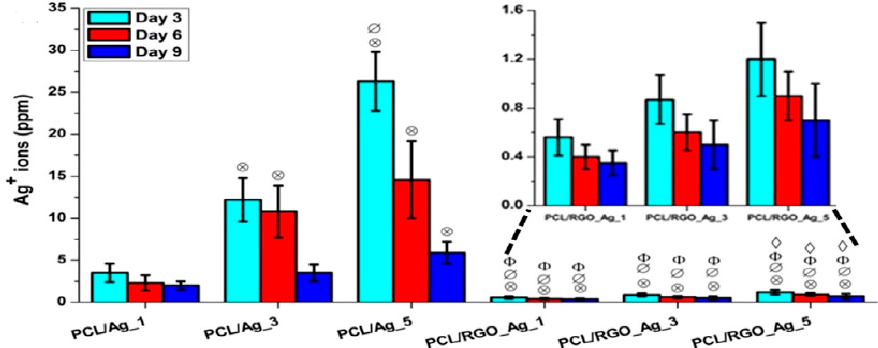
Figure 29. Released silver ions from PCL/Ag and PCL/RGO-Ag composite systems in pure water at 37 °C. Inset shows the enlarged view for values for PCL/ RGO-Ag system. Statistically significant differences ( p < 0.05) compared to PCL/Ag_1 and PCL/Ag_3 and PCL/Ag_5 and PCL/RGO_Ag_1 are indicated by ⊗ , ∅ , Φ and ♢ , respectively . Reproduced with permission from [187], Copyright Elsevier, 2016.